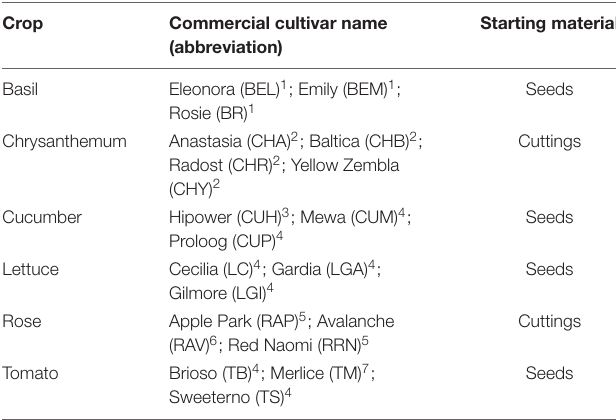
TABLE 1 | Horticultural genotypes used in the experiment, with abbreviations used throughout the text in brackets, and starting plant materials.